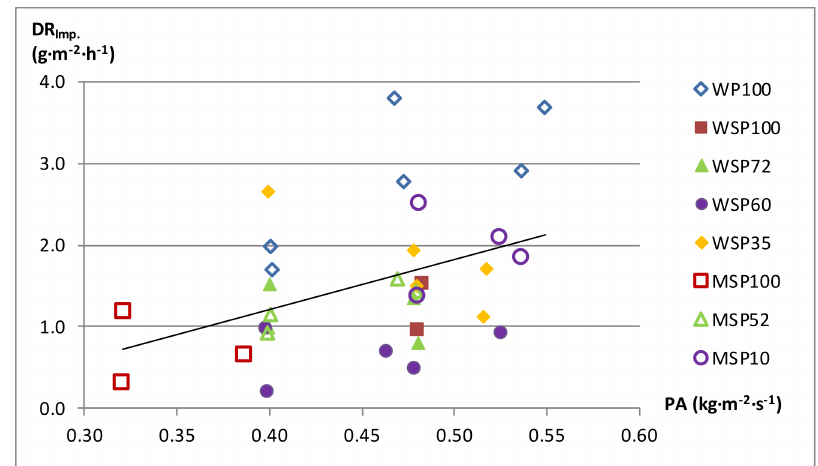
Figure 12. Deposition rates by inertial impact versus